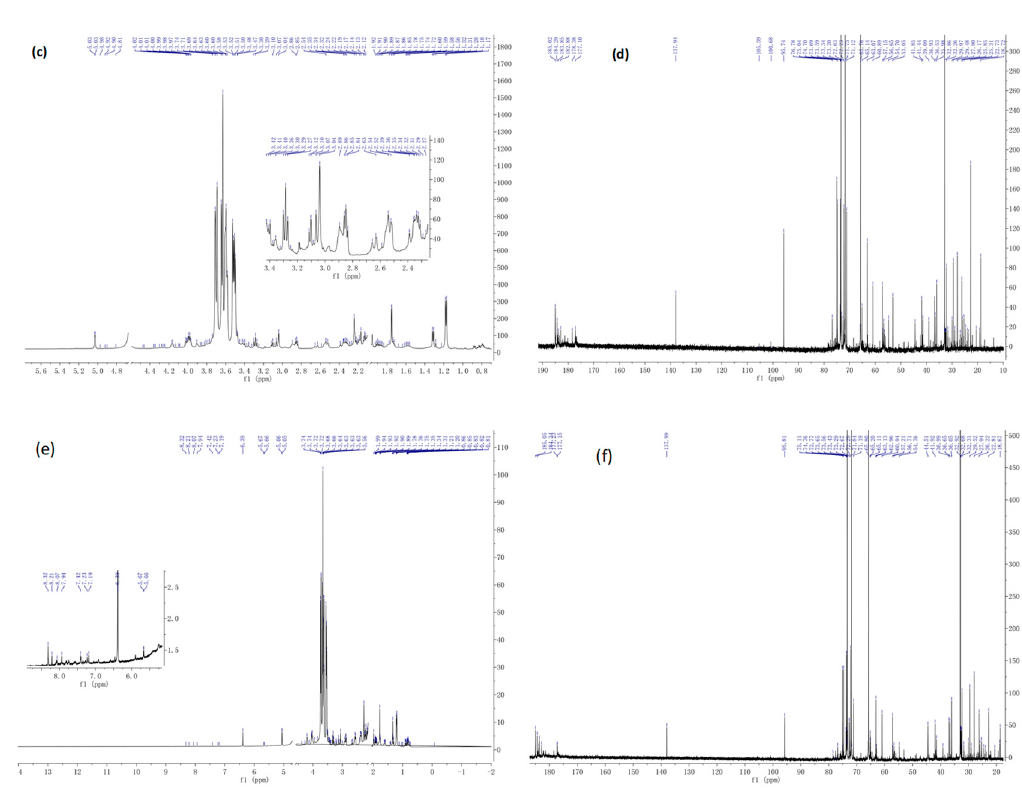
Figure 2. NMR spectra of three polysaccharides fractions. ( a ) 1 H NMR spectrum of FA; ( b ) 13 C NMR spectrum of FA; ( c ) 1 H NMR spectrum of FB; ( d ) 13 C NMR spectrum of FB; ( e ) 1 H NMR spectrum of FC; ( f ) 13 C NMR spectrum of FC.